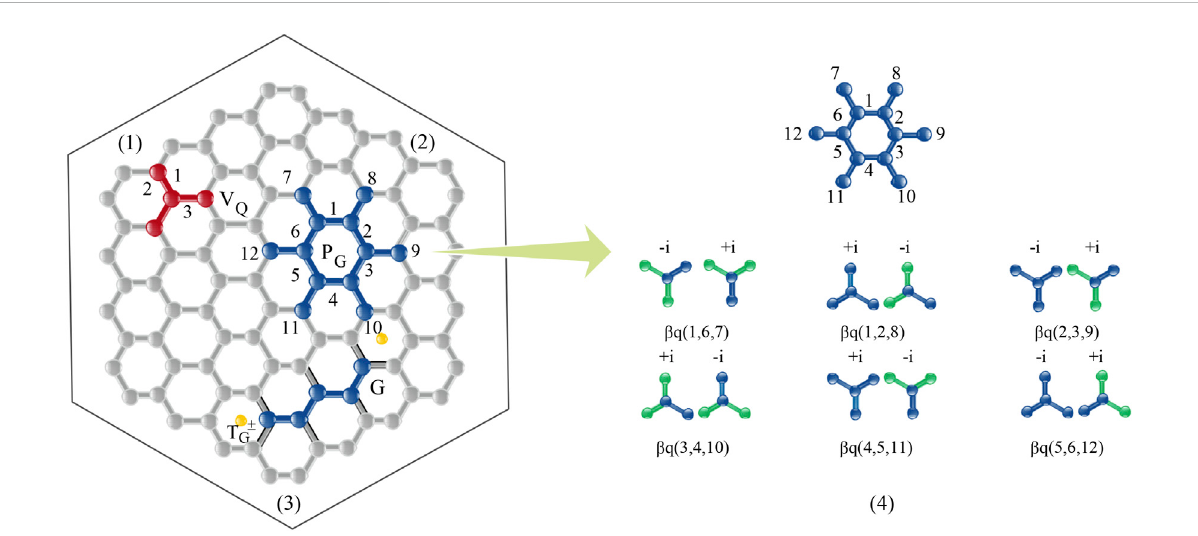
FIGURE 1 Hexagonal lattice diagram, the outermost hexagonal frame is only for aesthetics and does not represent a bounded hexagonal diagram. (1) Vertexoperator V Q .(2)Plaquetteoperator P G ,theplaquetteoperatornotonlyincludesthebluehexagon,butalsotheoutputtinglegsconnectingthe hexagon. (3)The path G of the positive or negative chirality string operator T ± G is represented by the blue path, the connecting line represents the T ± G support Conn ( G ), and the yellow dots represent a pair of vertex excitations generated at the endpoints of the path G . (4)Phase factor diagram expanded from